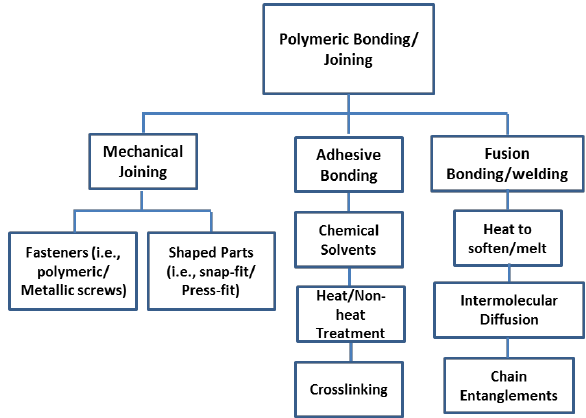
Figure 1. Possible joining techniques for polymeric materials. The concept has been redesign on the basis of ref. [6].